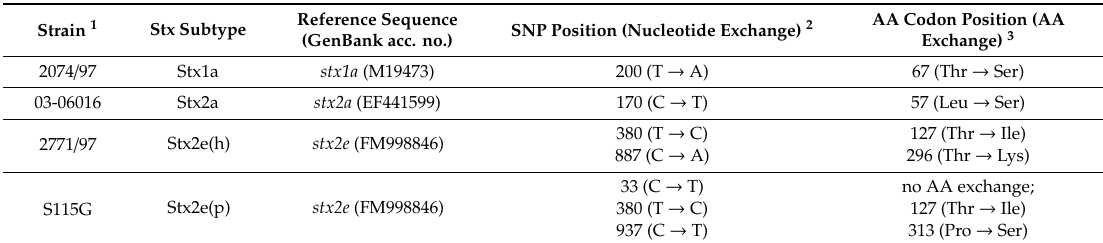
Table 1. Single nucleotide polymorphisms and amino acid exchanges of Stx subtypes used in this study. Reference Sequence Strain 1 Stx Subtype (GenBank acc.